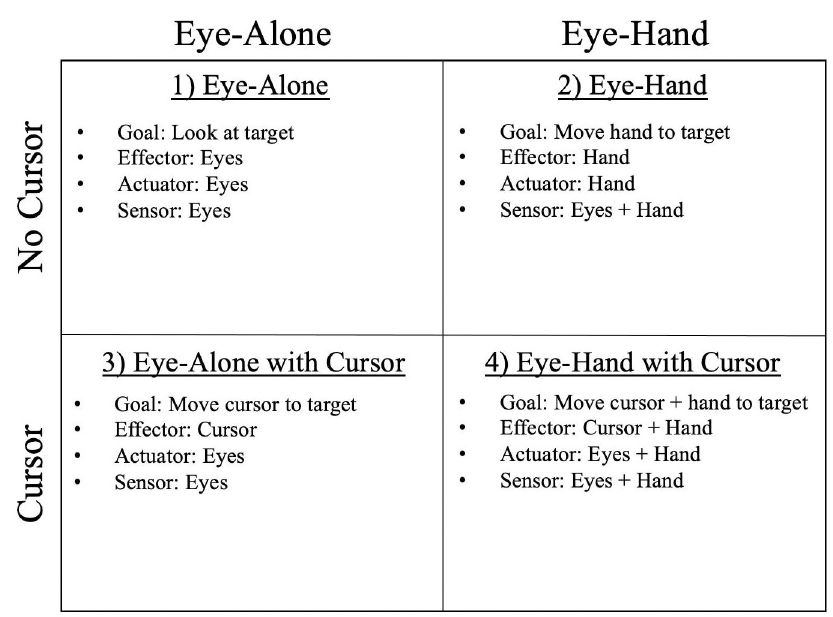
Fig 1. Experimental conditions. Summary of important characteristics for each experimental condition. Conditions were characterized by different combinations of goal, effector, actuator, and sensor. Each participant performed all experimental conditions in a randomized